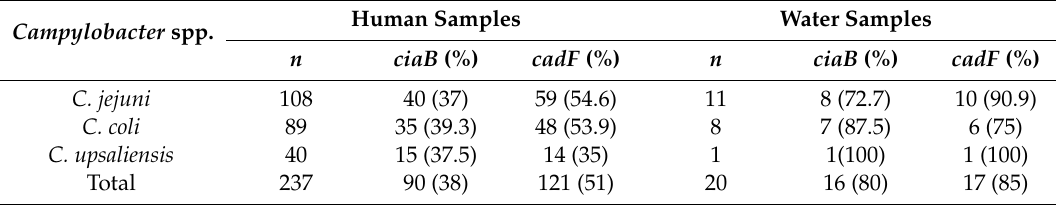
Table 7. Distribution of virulence genes according to Campylobacter